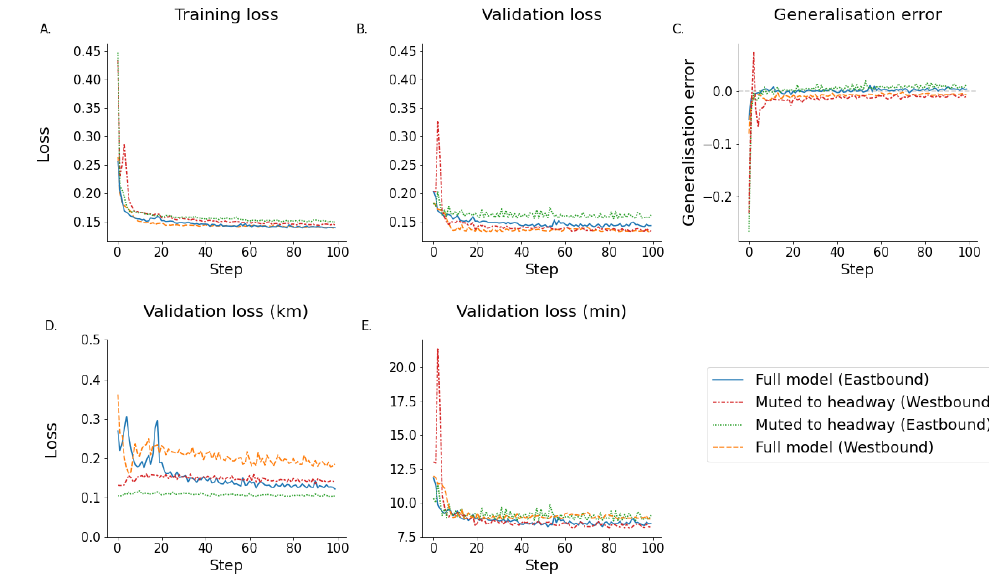
Figure 11. The model was muted to the headway meaning only vehicles ahead of the target were included. This shows a clear performance increase in both the training an testing dataset for both directions.( A ) shows the training loss. ( B ) shows the validation loss. ( C ) shows the generalisation error calculated by subtracting the training error from the testing error. ( D ) shows the estimated validation error in km. ( E ) shows the estimated validation loss in minutes. (Note that subfigure ( D ) has a truncated y axis for illustration